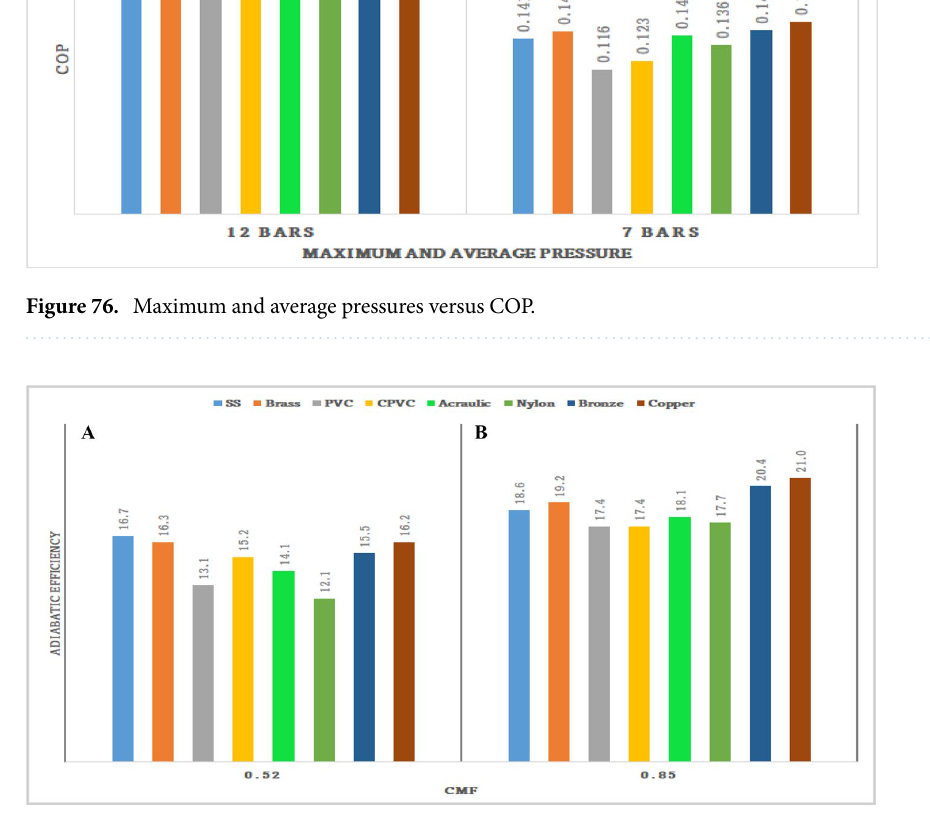
Figure 77. Average and maximum CMF versus adiabatic efficiencies (η adia ).